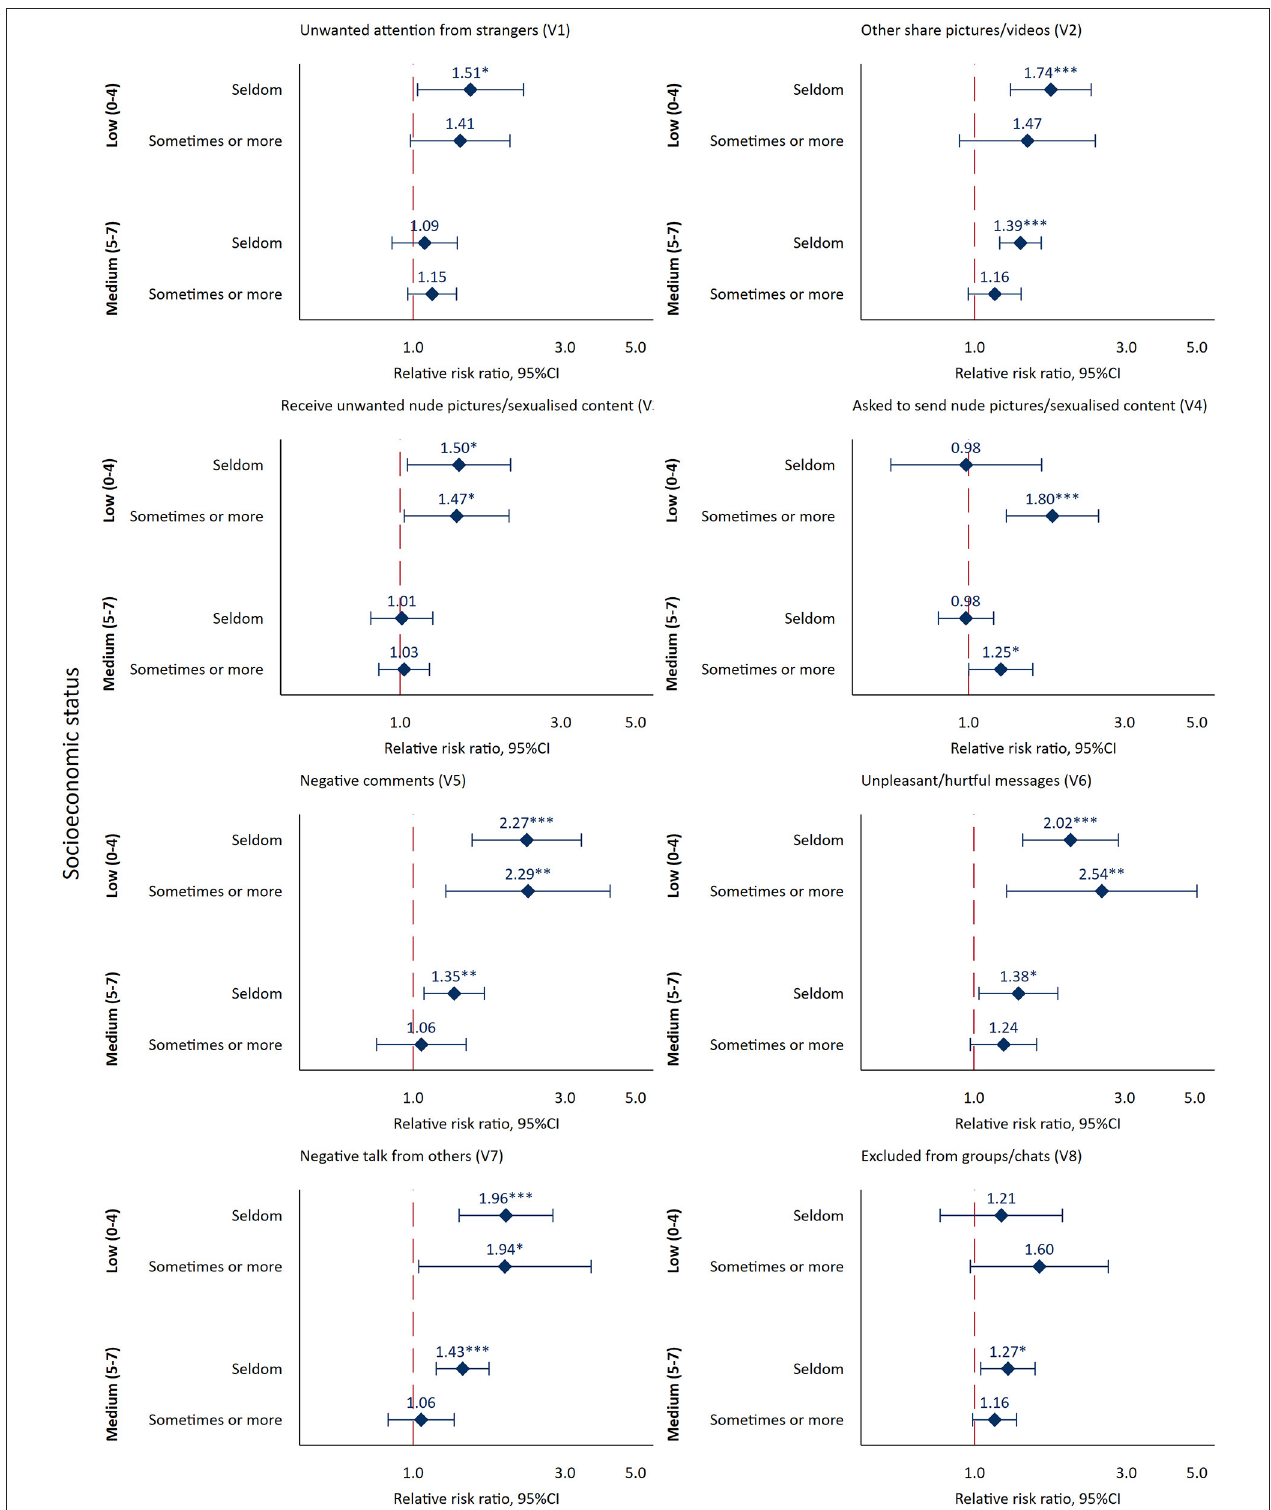
FIGURE 2 | Results from multinomial logistic regression across negative experiences on social media. Subjective socioeconomic status as independent variable [reference group: high socioeconomic status (SES; 8–10)] and negative experiences (base category: never) on social media as dependent variable. Adjusted for age and gender. Estimates based on multiple imputation while accounting for school-level clustering. Base category: Never; Reference group: High SES (8–10); * p < 0.05, ** p < 0.01, *** p < 0.001. Red dotted line indicates no difference in relative risk.